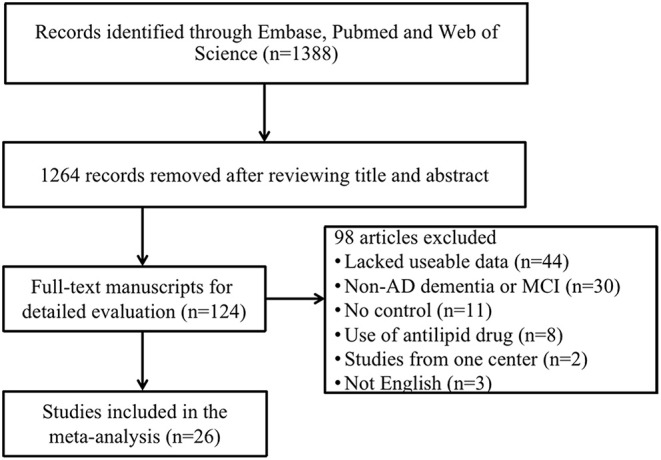
Flow chart of study selection in the meta-analysis. AD, Alzheimer's disease; MCI, mild cognitive impairment.